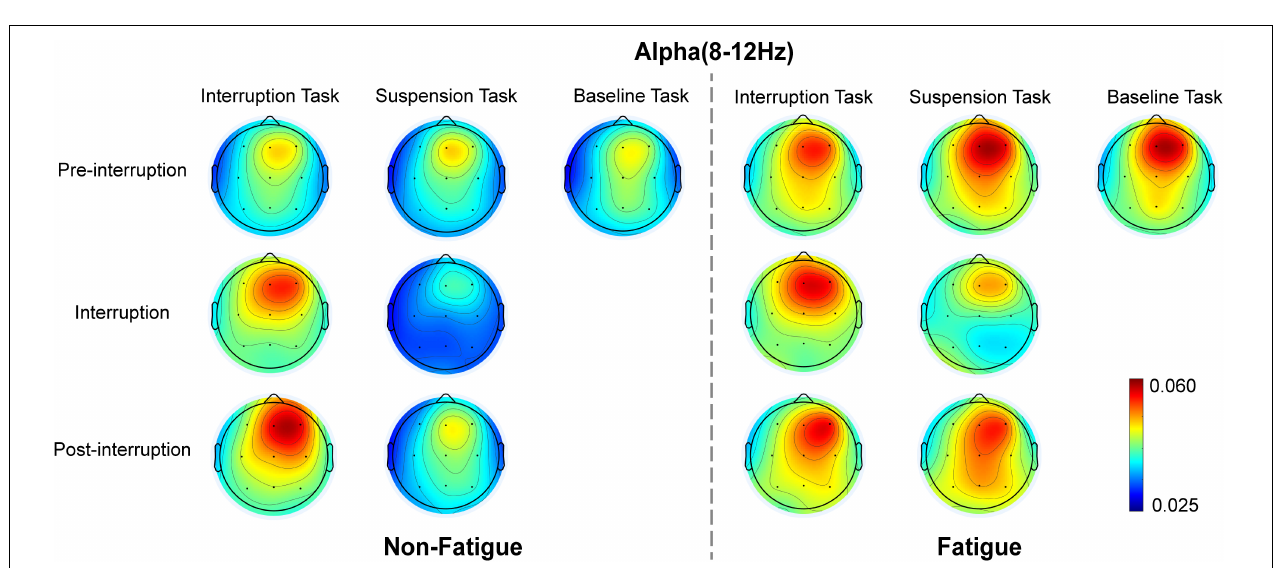
FIGURE 9 | Mean relative theta energy in various conditions. Error bars indicate 95% CIs.